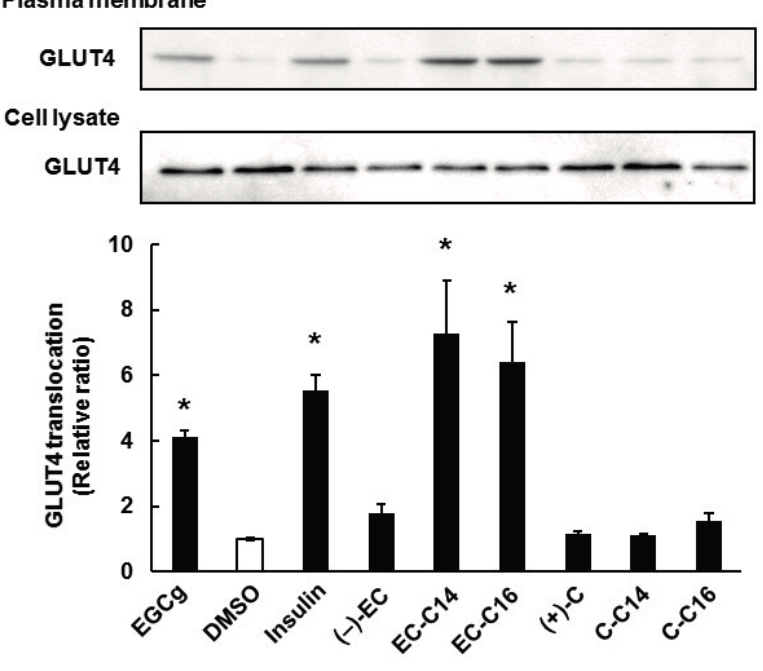
Figure 3. The effect of 3- O -acyl-catechins on GLUT4 translocation in L6 myotubes. Differentiated L6 cells were incubated with catechins and 3- O -acyl-catechins at 100 nM for 15 min. GLUT4 in the plasma membrane and the cell lysate were detected by Western blot analysis. Band density was determined by ImageJ analysis software. Data are shown as the mean ± SE ( n = 3). * p < 0.05 vs. DMSO-treated control cells by a Dunnett multiple comparison